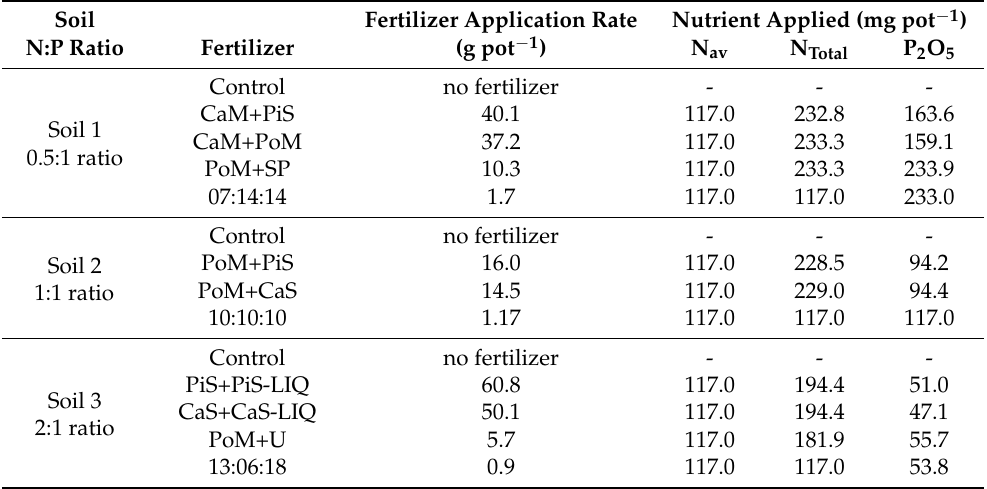
Table 3. Fertilizer application rate in each treatment (g pot − 1 ) and the correspondent nutrients applied (g pot − 1